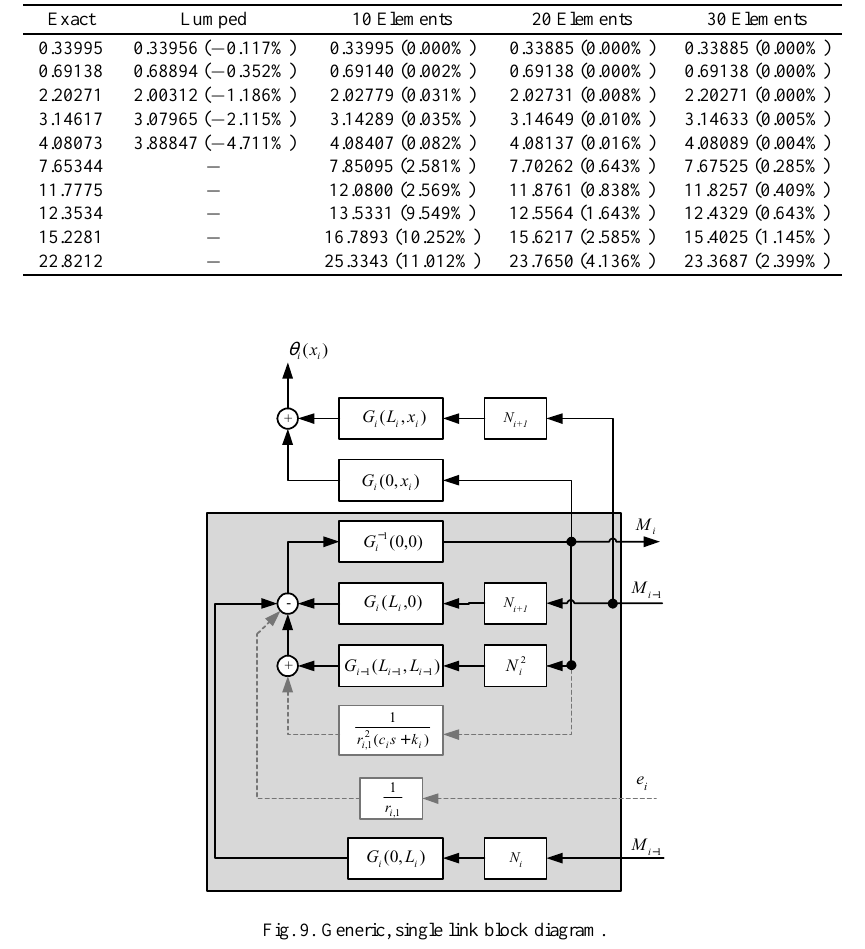
Table 2 Natural frequencies and approximation errors of the system in Example 1 (kHz)